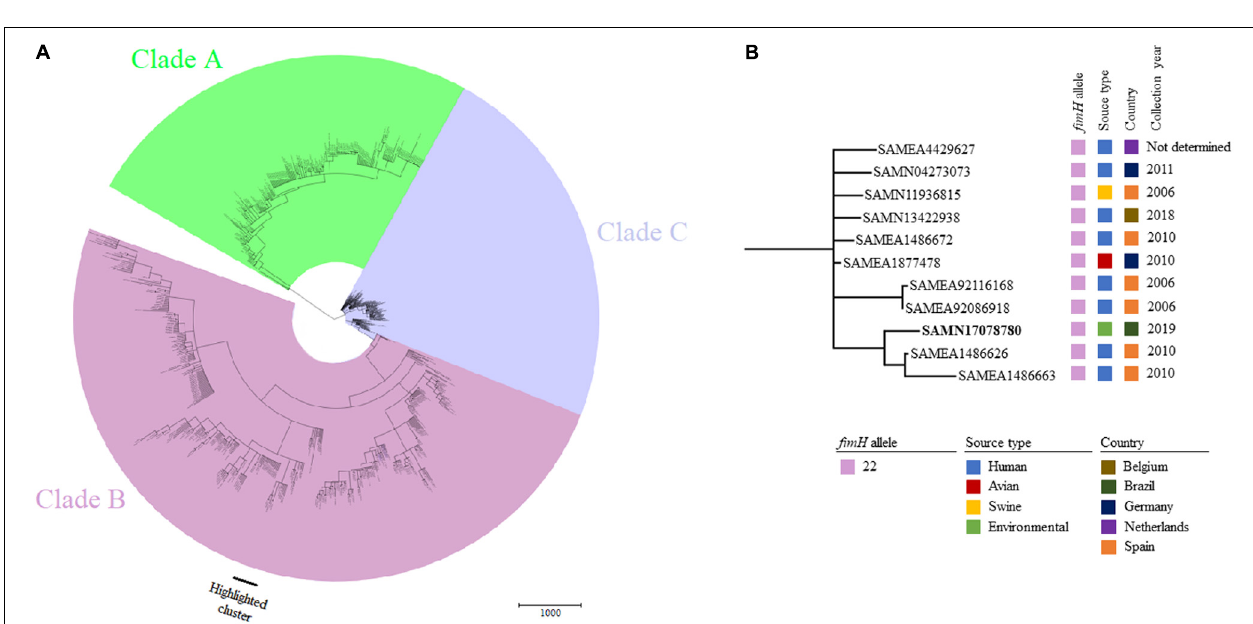
FIGURE 2 | (A) Minimum spanning tree based on wgMLST of 850 worldwide distributed E. coli strains belonging to ST131. (B) Highlighted cluster containing E. coli S802 (BioSample accession indicated in bold) and showing the fimH allele, source of origin, country, and collection year of closely related strains.